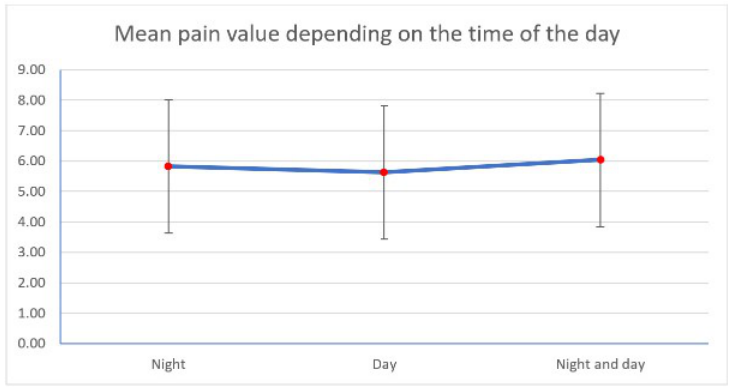
Figure 6. Graphical representation of pain value depending on the time of the day.